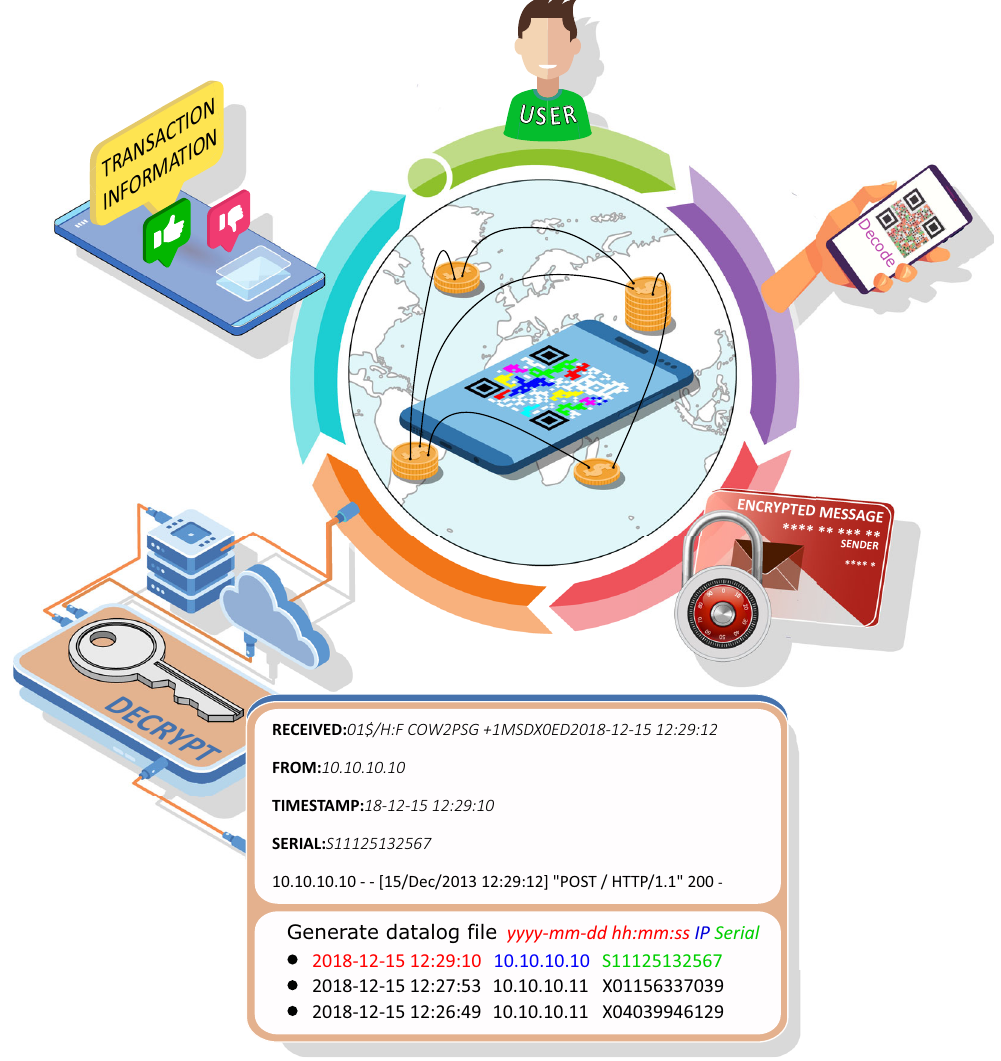
Fig. 4 Transaction process diagram. The QR code is decoded and the encrypted information is sent to a server/cloud service that has the key to decrypt the received information. An alert can be trigged with the transaction information and transmitting to the client Supplementary Information. The structures of non-hydrolyzed organic- inorganic hybrid precursor, and of the complexes are illustrated in Supplementary Fig. 1. Supplementary Information contains details of structural (X-ray diffraction, scanning electron microscopy with energy- dispersive X-ray, Fourier transform infrared (FT-IR) spectroscopy) and optical characterisation (photoluminescence and hyperspectral imaging) of the fabricated materials, Supplementary Figs. 2 – 11. To enable the materials processing as inks to be printed in a commercial inkjet printer, the viscosity was controlled and measured using a Brook fi eld DV- II + Pro viscometer using the Enhanced Brook fi eld UL Adapter. The viscosity values were set as 5.02 cP and 2.34 cP (at 20 °C) for dU6Eu and dU6Tb, respectively. Printing process The multiplexed QR code was printed with dimensions 4.5 × 4.5 cm 2 in order to fi t within the banknote and to ensure reading, considering an optimised distance between the CCD camera of the smartphone and the QR code (0.2 m, Supplementary Fig. 14 and more details in Supplementary Information). The fi rst access level modules, with a dot-shaped, was printed with black colour, using a commercial laser printer (Xerox Colour C60) over with 90 ± 3% g/m 2 (ISO 536), opacity 90 ± 3% (ISO 2471) and roughness 1100 ± 300 mL/min (ISO 8791-2) according to the manufacturer. The